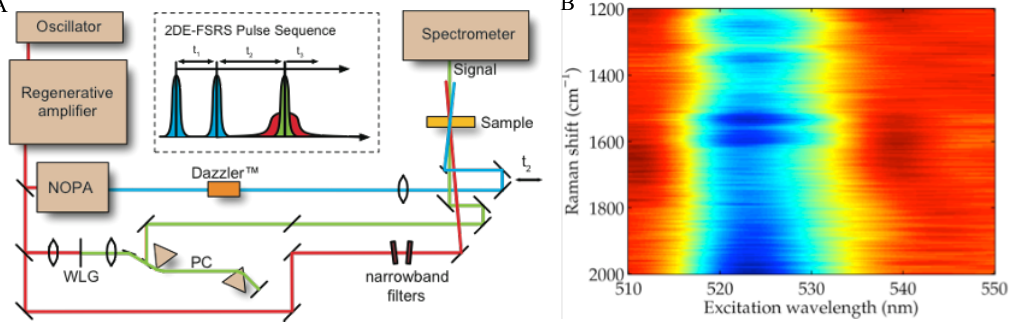
Fig 1: A: Experimental setup for 2DE-FSRS. (NOPA: noncollinear optical parametric amplifier, WLG: white light generation in a sapphire plate, PC: prism compressor) B: 2DE-FSRS spectrum of rhodmamine 6G in ethanol at a waiting time of 300